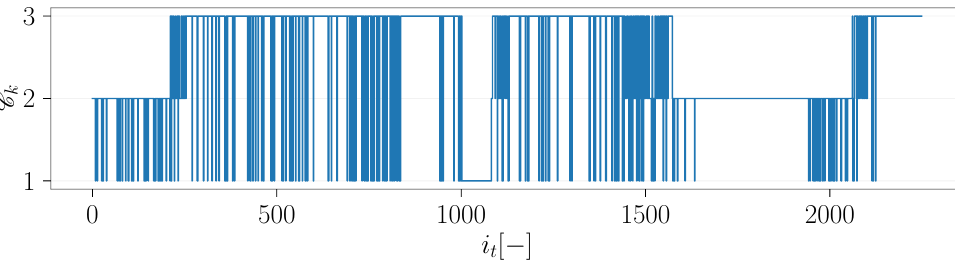
Figure 29. Visualization of the number of transitions from cluster C k to cluster C j for setup 2.